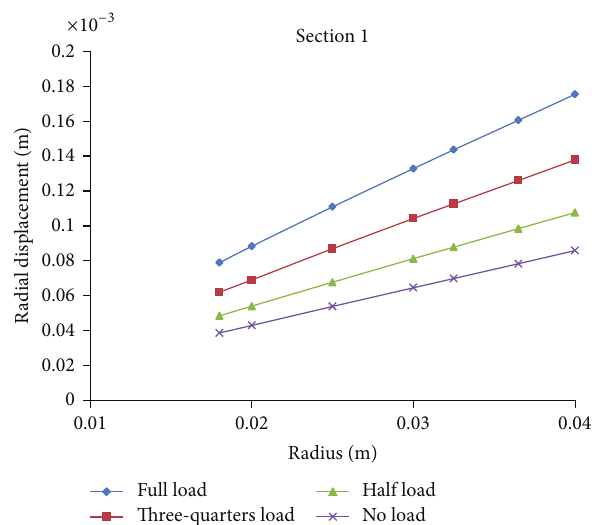
Figure 11: Radial displacement at section